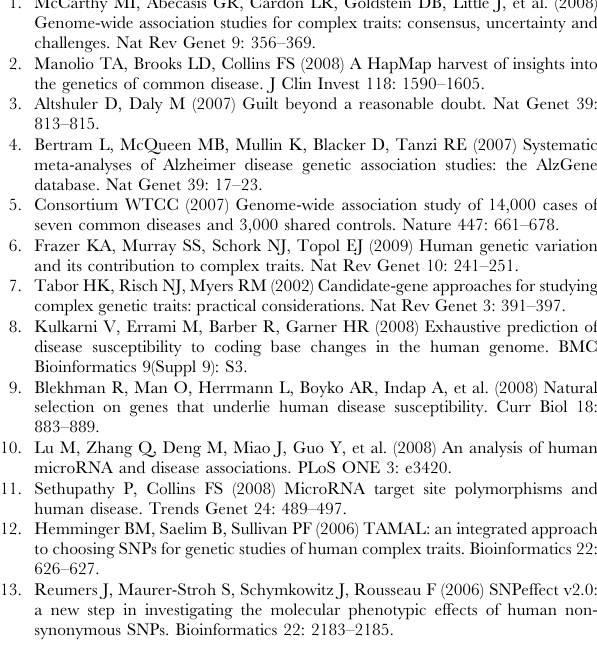
Found at: doi:10.1371/journal.pone.0014480.s003 (0.05 MB